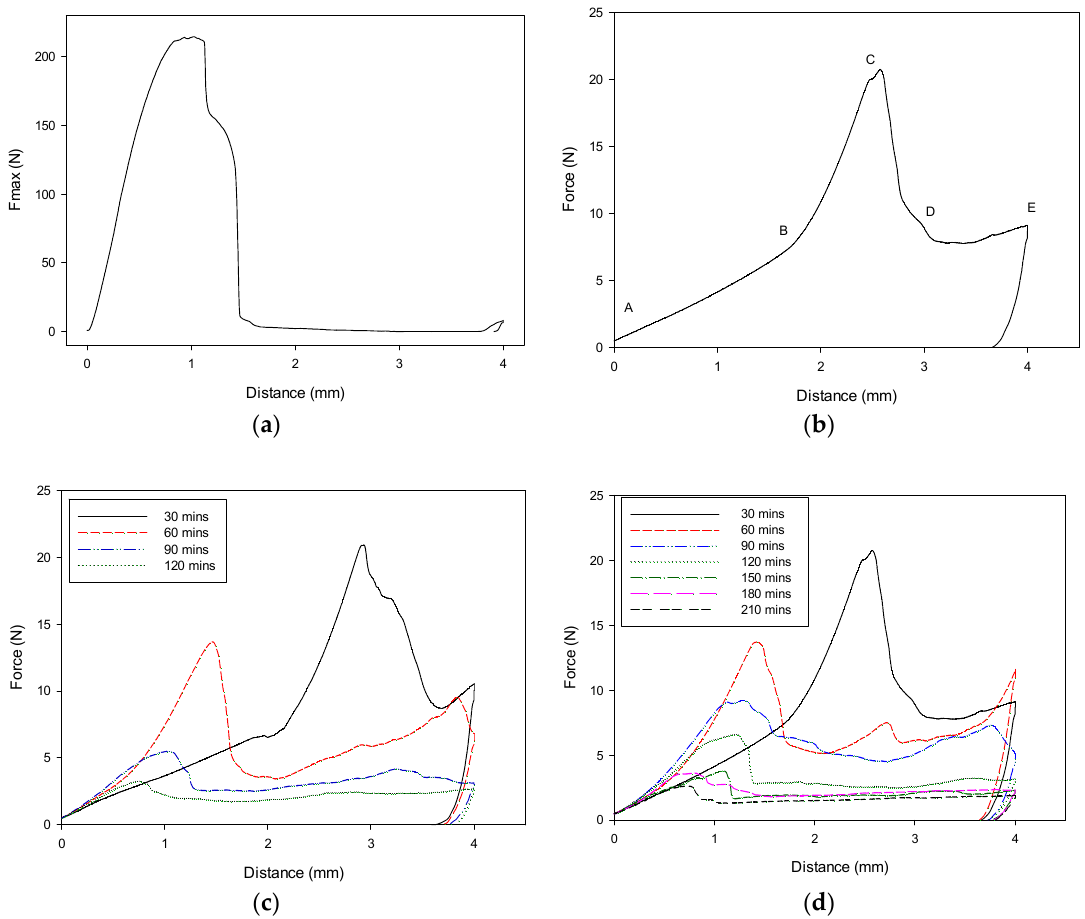
Figure 3. Variation of force deformation in common beans: ( a ) typical uncooked beans ( b ) typical cooked beans ( c ) cooked ETC cultivar (Masusu), and ( d ) cooked HTC cultivar (Msiska).